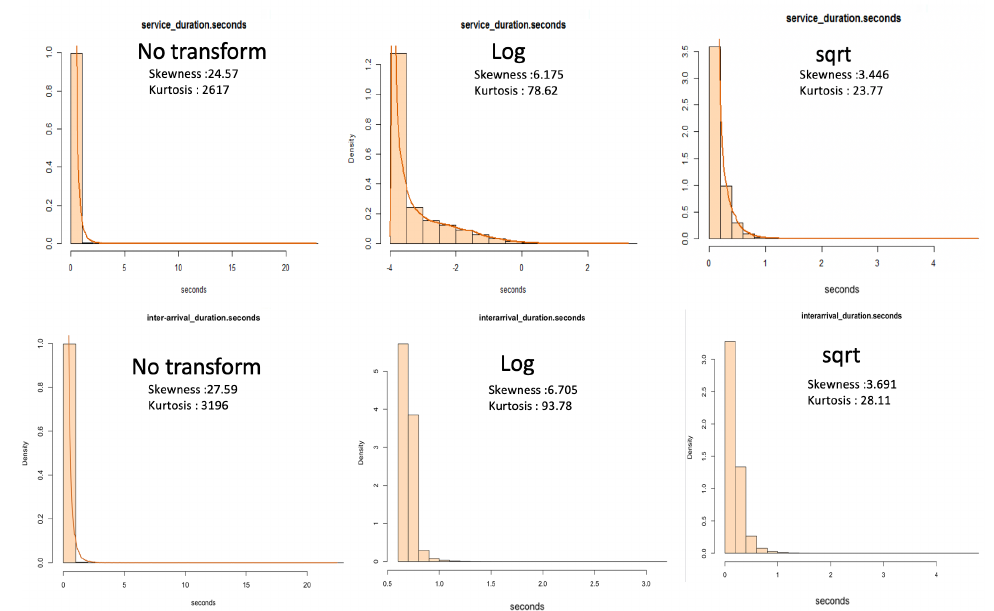
Figure 6. Histogram: Normal Period: Service And Inter-arrival